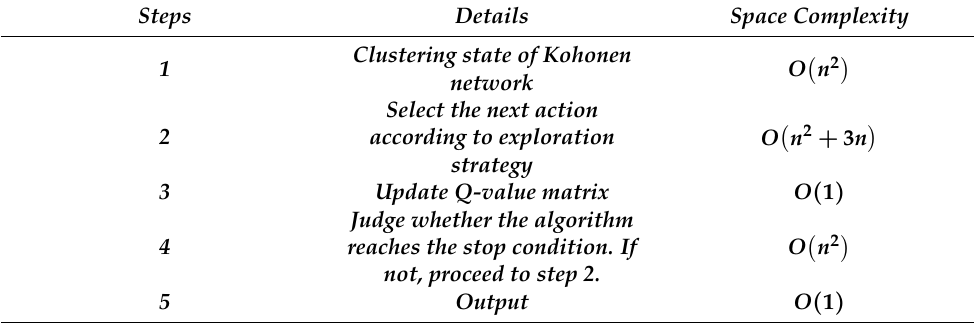
Table 2. Time complexity